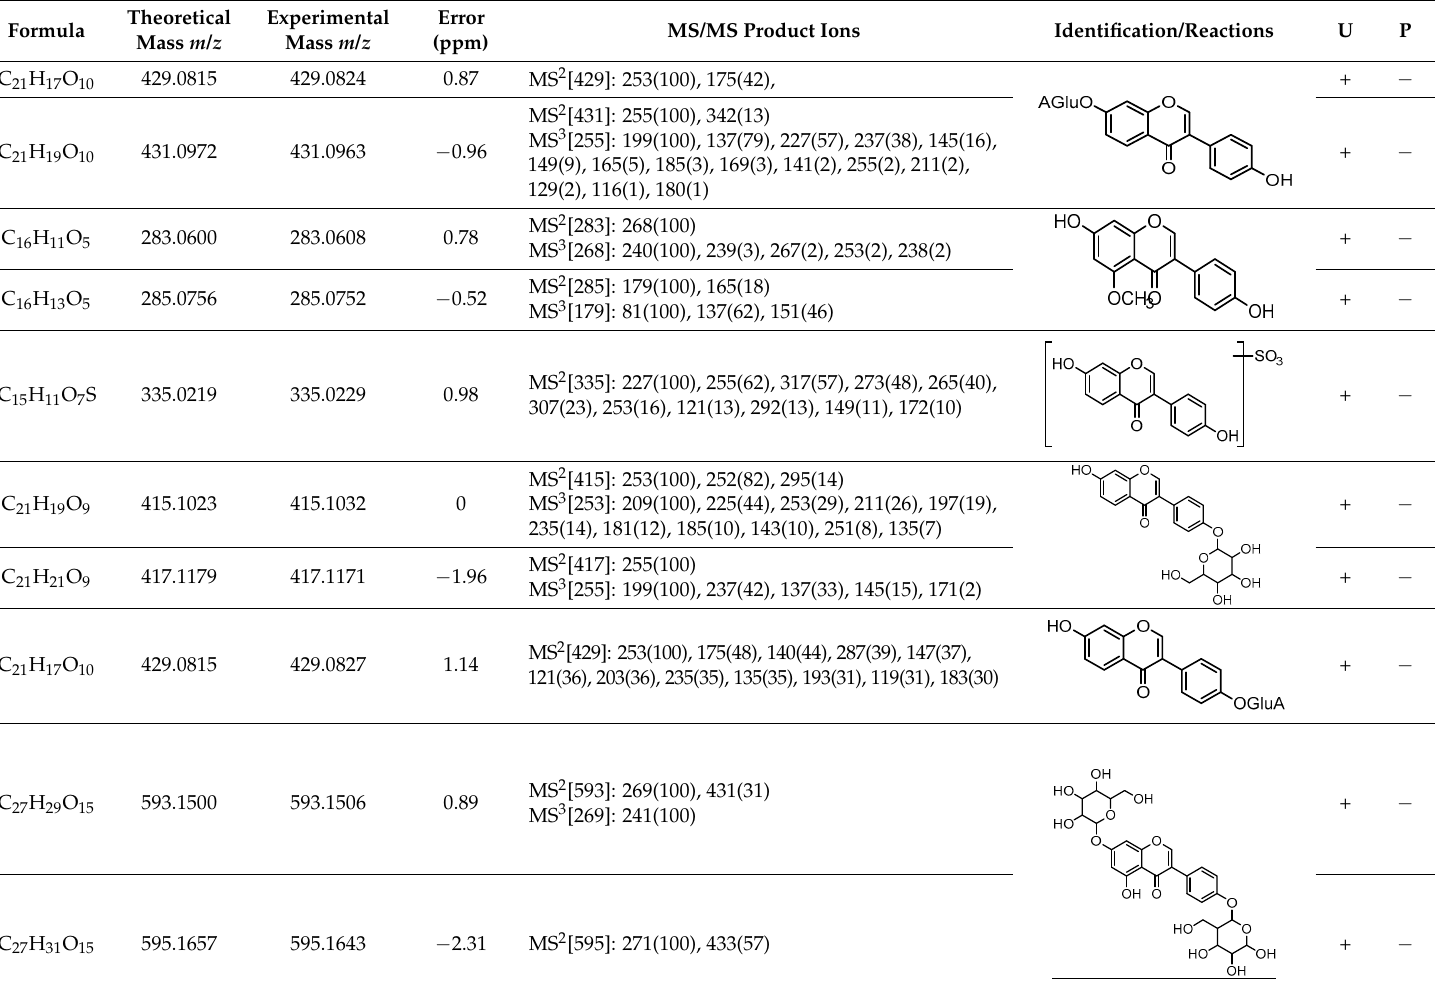
Table 1. Summary of daidzein metabolites in rat urine and